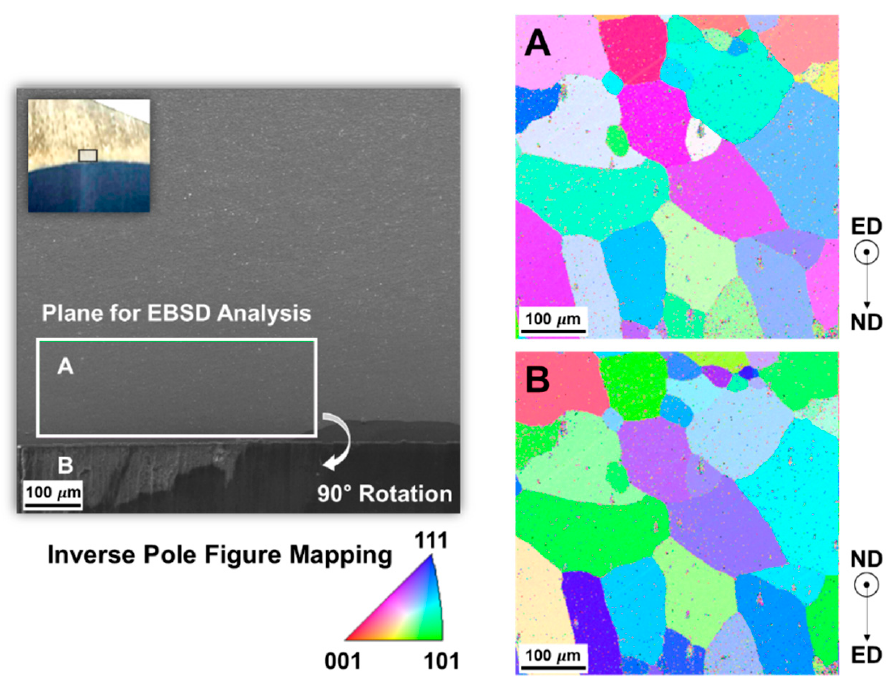
Figure 18. Inverse pole figure maps of the defective region: ( A ) parallel; and ( B ) perpendicular to the extrusion direction.